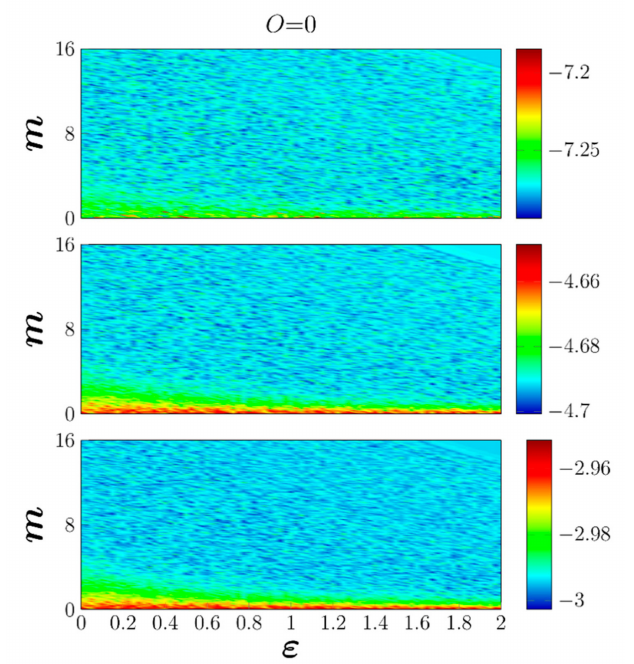
Figure 8. The log10 of the norm of the error of approximating the given function f ( x ) and its first two derivatives using Gaussian RBF-TPU with zeroth truncation order for a range of ε and m values. The rows are for function, first derivative, and second derivative approximations. The ε k range is [ − 1, 1] and N e = 5.